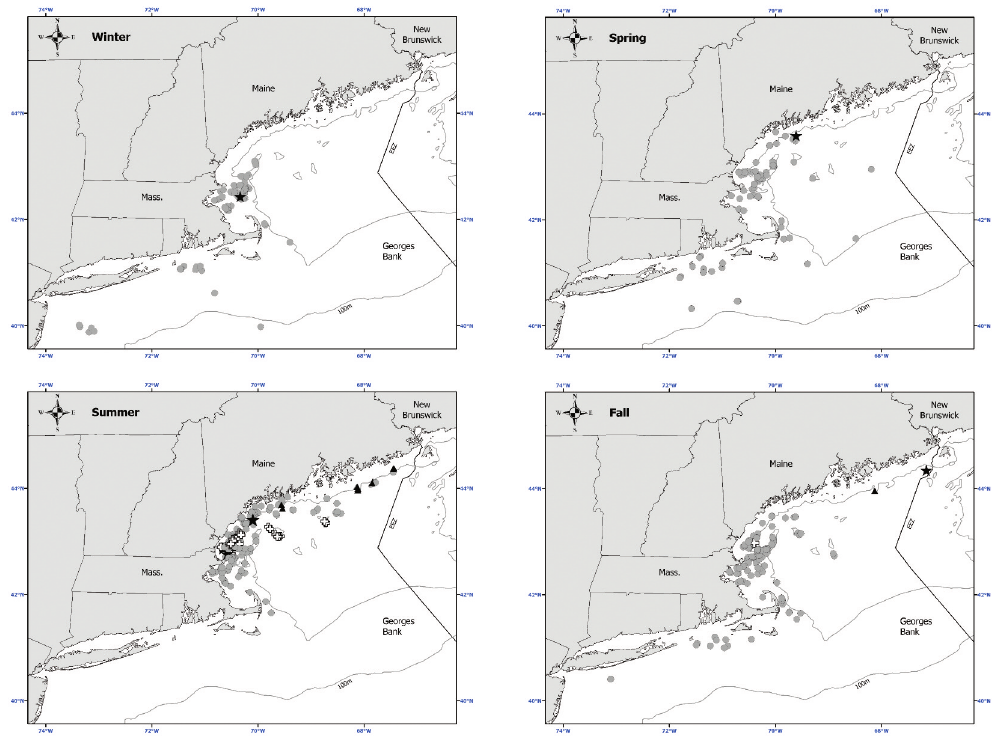
Fig. 3. Observed harbour seal by-catch by gear and season in U.S. Atlantic fisheries (1989- 2006). Star symbols are bottom otter trawl, circles are anchored sink gillnet, crosses are drift sink gillnet and triangles are herring purse